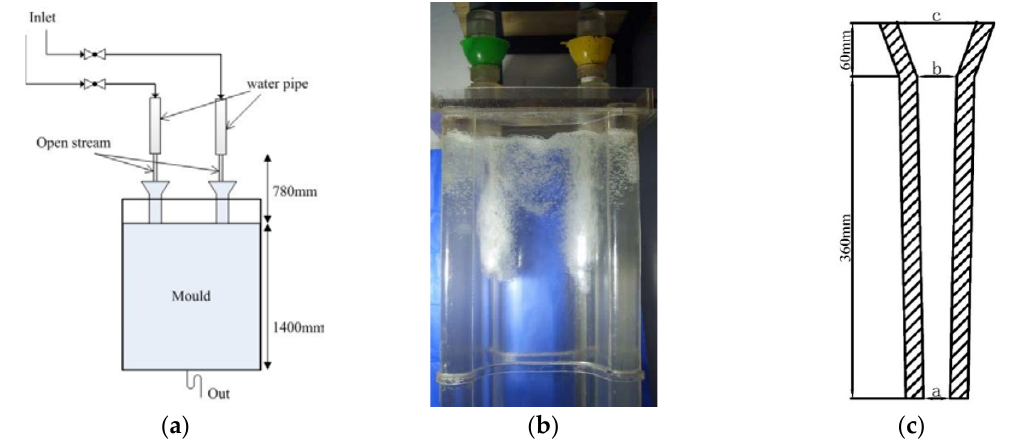
Figure 2. Schematic illustration of 435 mm × 320 mm × 90 mm beam blank mold.